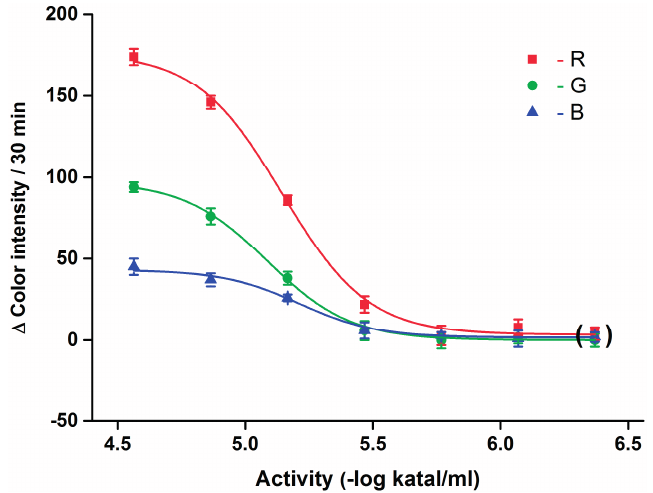
Figure 4. Calibration of the smartphone-based assay using diluted plasma samples. Differences of color intensity for the R, G and B channels are given. These were acquired by processing photographs taken at the beginning (0 min) of the assay and after 30 min. Points in brackets was taken by assay of pure PBS. Error bars indicate standard deviations for n =